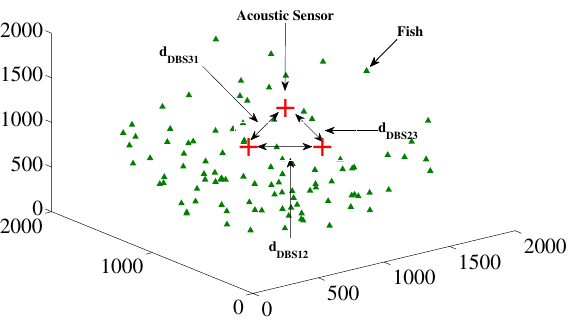
Figure 3. A distribution of fish and mammals with three equally spaced acoustic sensors for AST scheme. Here, the axes units are in meter. We used MATLAB R2010a to achieve this